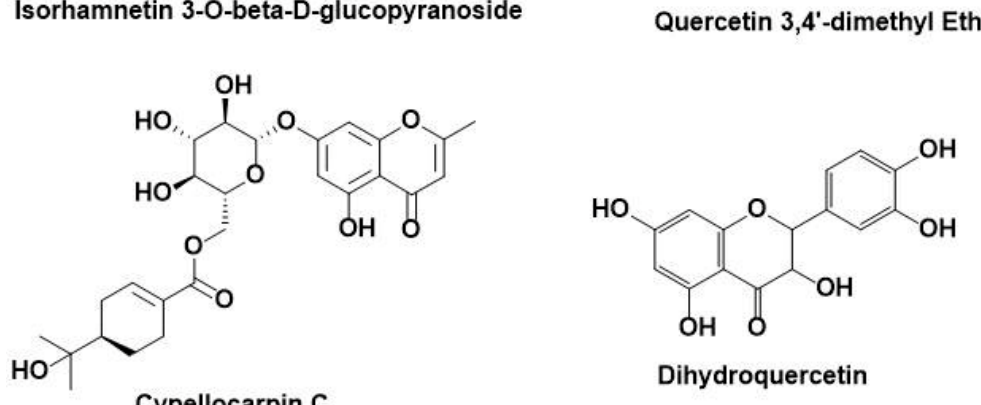
Figure 2. Chemical structures of phenolic compounds isolated from Eucalyptus globulus as well as some major annotated compounds by HPLC-DAD-ESI-MS/MS.